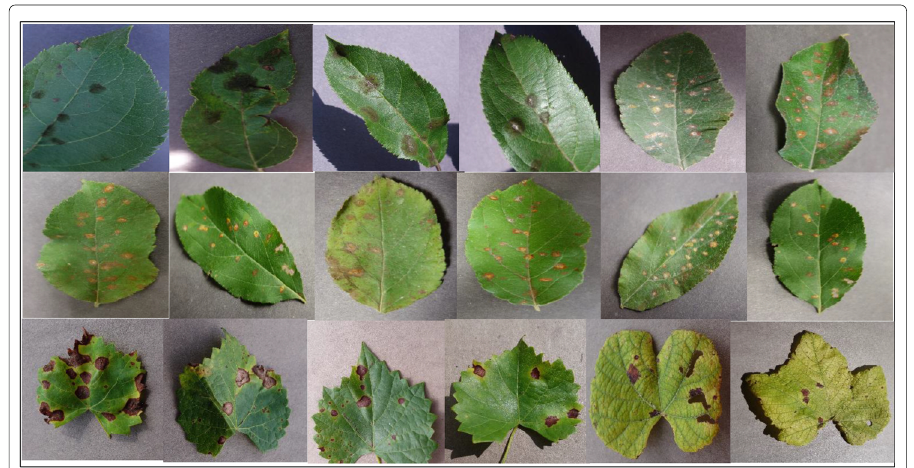
Fig. 14 Sample selected images for